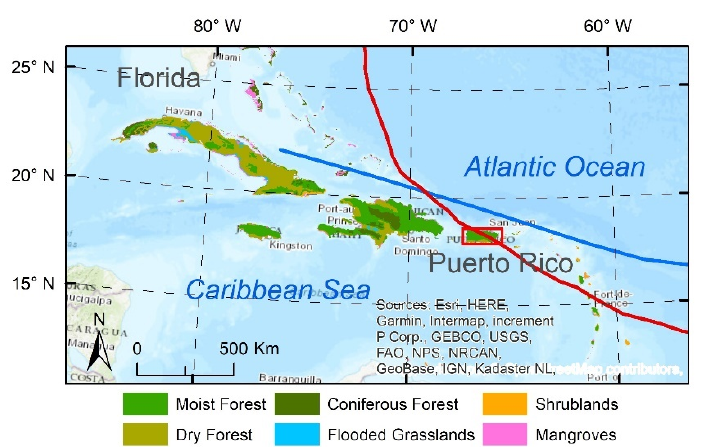
Figure A1. Location of Puerto Rico in the Caribbean. The blue and red lines are the paths of Hurricane Irma and Hurricane Maria, respectively.